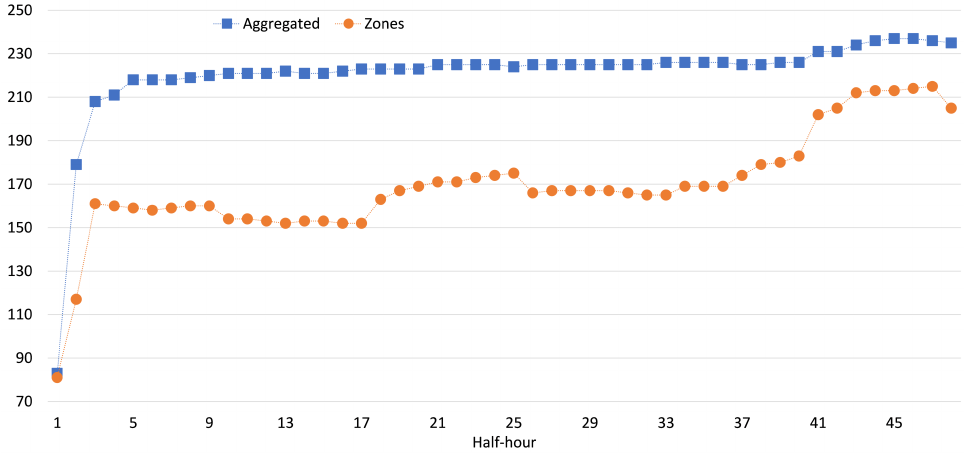
Figure 12. Total number of thermal units committed in Case 1 Trial